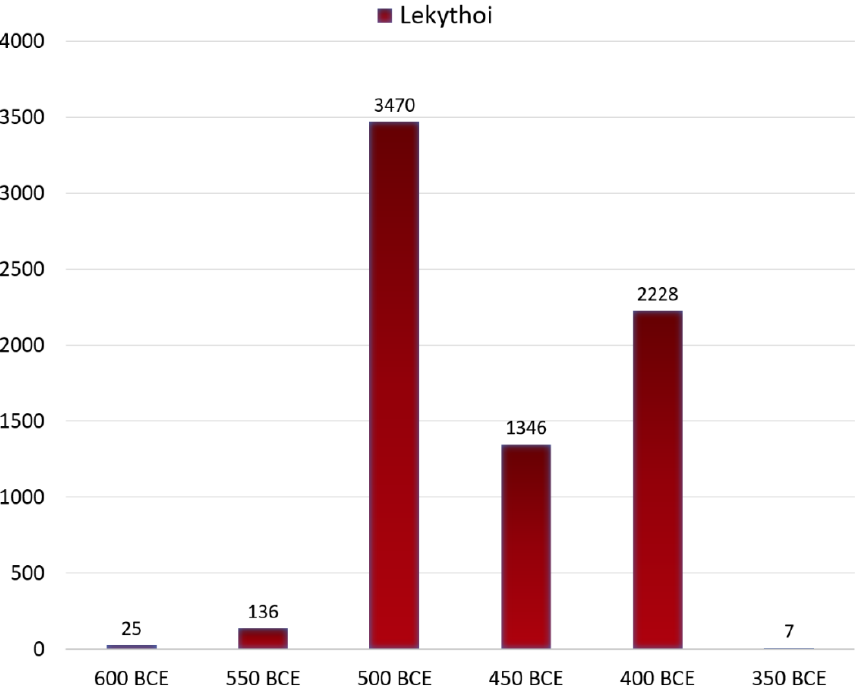
Figure 8. Relative numbers of Athenian vase-paintings featuring women in the imagery on lekythoi grouped by approximate dates. Data from the BAPD. Chart created by author.